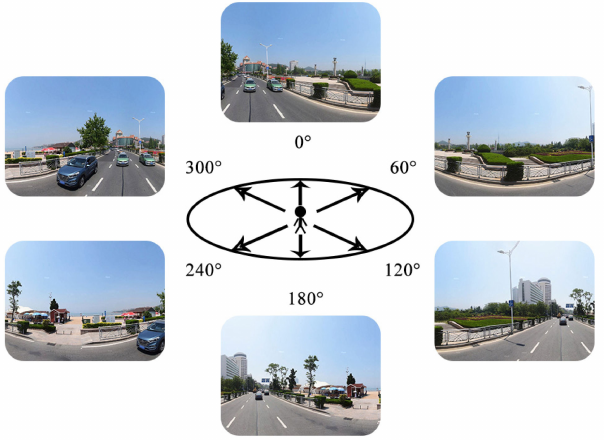
Figure 3. Collection of BSV images of sample